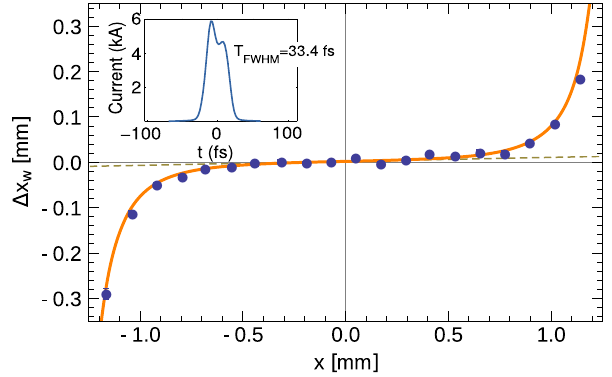
figure.FIG. 3. Deflection as function of beam offset from the axis in the horizontal dechirper module, showing data (plotting symbols) and calculations (curves), for half gap a ¼ 1 mm. Note that the error bars in the data are small and not visible. For the simulated curves, the gap parameter was reduced by 11% to fit the experimental data. The tilted straight line gives the slope of the curves at the origin. The bunch shape, with head to the left, is given in the inset